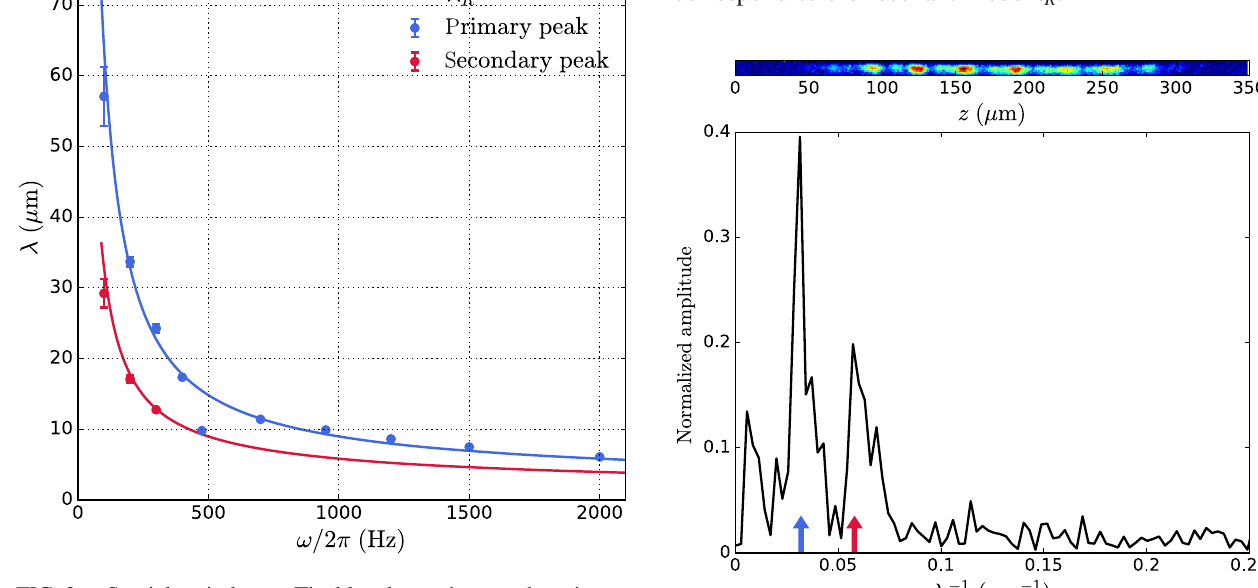
FIG. 2. Spatial period vs ω . The blue data points are the primary peak of the FFTs, while the red data points correspond to a secondary peak, where one exists. The error bars here, and in each subsequent figure, correspond to the standard error of the mean determined from ten different experimental runs for each point. The solid blue line is the calculated spatial period λ Faraday mode, while the red is that of the resonant mode λ The resonant mode dominates only when ω is tuned to resonance at ω , producing the observed primary peak. r